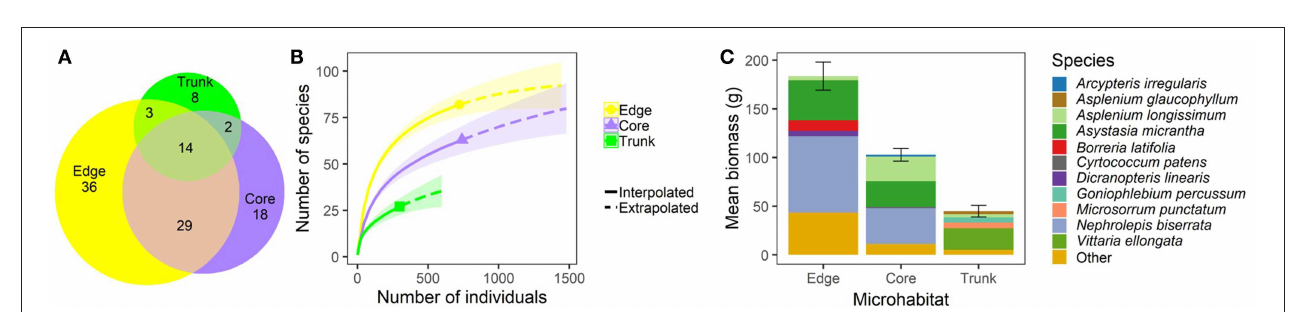
FIGURE 1 | Vegetation within 1 m 2 quadrats across different microhabitats (understory at plot edge, “Edge”; understory at plot core, “Core”; and oil palm trunk, “Trunk”) within BEFTA Understory Vegetation Project experimental plots during the pre-treatment phase of the experiment. During this time, all plots were being managed using Normal understory vegetation management practices. Panel (A) shows total plant species richness per quadrat; (B) total plant biomass per quadrat; (C) total plant percentage cover per quadrat. Boxplots show median and interquartile range, with outliers being shown as circles. Mean values are shown by black diamonds. Significant differences between microhabitats are indicated by asterisks: *** p < 0.001, ** p < 0.01. Refer to Supplementary Table 1 for full values.